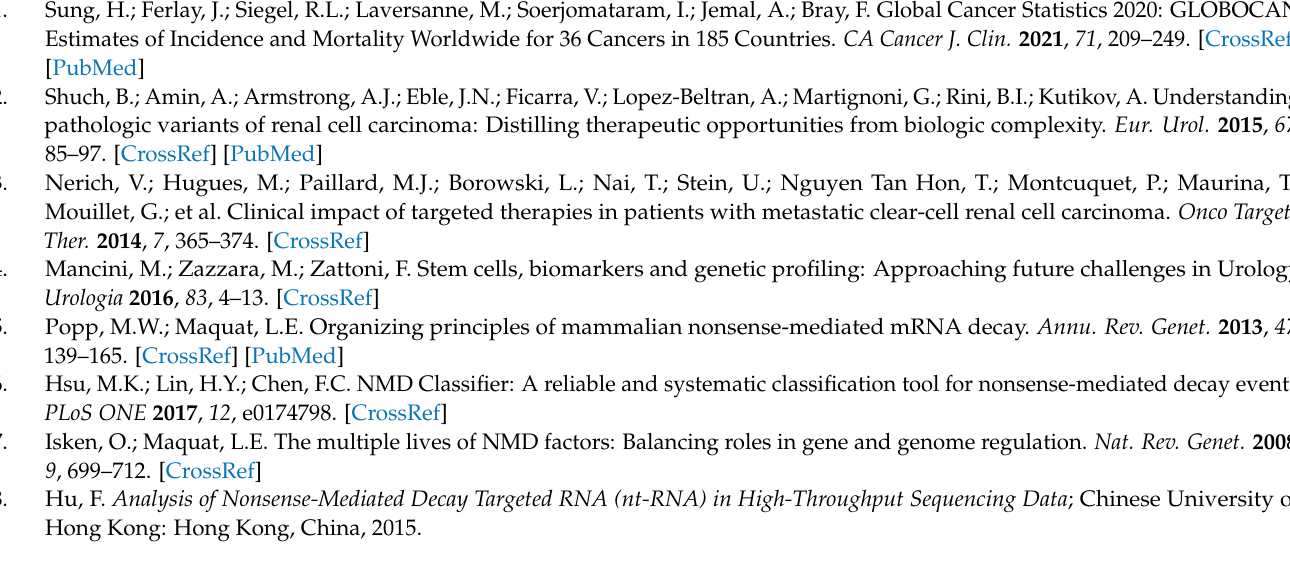
dataset; Table S1: List of 533 KIRC samples; Table S2: List of 72 normal samples; Table S3: List of 296 HEntRNAs; Table S4: ntRNA–miRNA interaction pairs from TargetScan database; Table S5: miRNA– lncRNA interaction pairs from LncBase2 database; Table S6: Core genes obtained by cytoHubba’s five methods; Table S7: Correlation between ABAT methylation probes and ABAT_33905_AP expression in